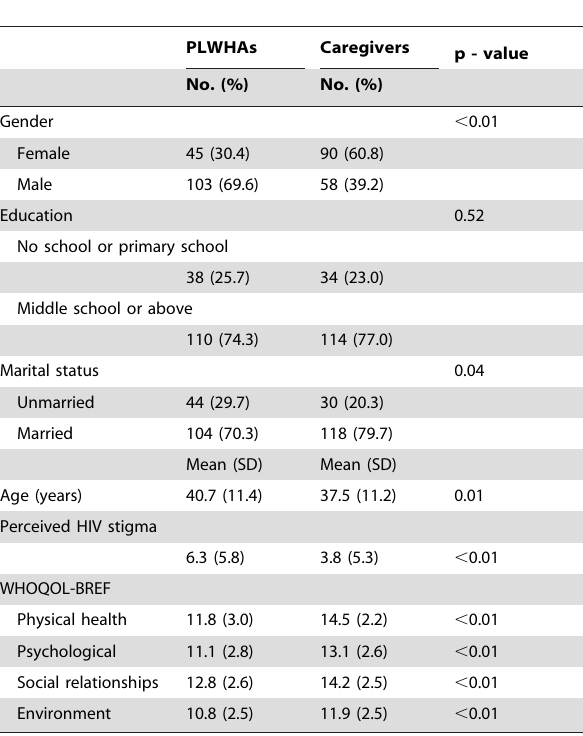
Table 1. Demographics, stigma and quality of life between PLWHAs 1 and caregivers.